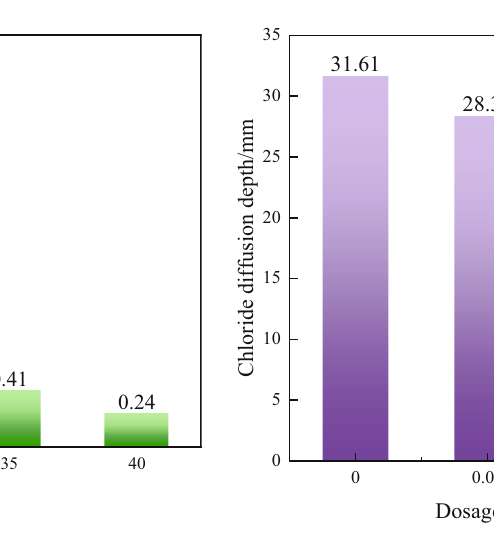
Figure 2: Chloride di ff usion depth of concrete with di ff erent dosage of MWCNTs [ 20 ] .